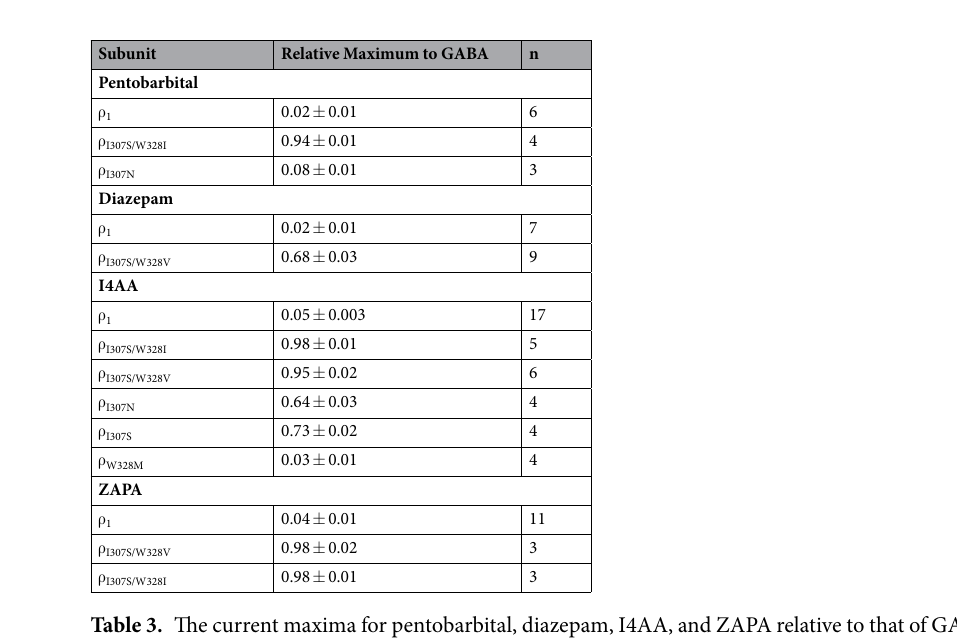
Figure 2. I4AA-, ZAPA-, pentobarbital-, and diazepam-dependent activation of ρ 1 307/328 mutants. ( a ) Pentobarbital (PB)- and diazepam (DZ)-induced current traces in the ρ 1 , ρ I307S/W328I , and ρ I307S/W328V receptors. The lines above the current traces represent the duration of the drug application. ( b ) GABA- and I4AA-evoked current traces in the ρ 1 , ρ I307S/W328I , and ρ I307S/W328V receptors. ( c ) The current maxima of I4AA, ZAPA, PB, and DZ relative to that elicited by GABA in the ρ 1 , ρ I307S/W328I , and ρ I307S/W328V receptors. ( d ) The GABA, I4AA, PB and DZ concentration-response relationships in the ρ 1 , ρ I307S/W328I , and ρ I307S/W328V receptors.